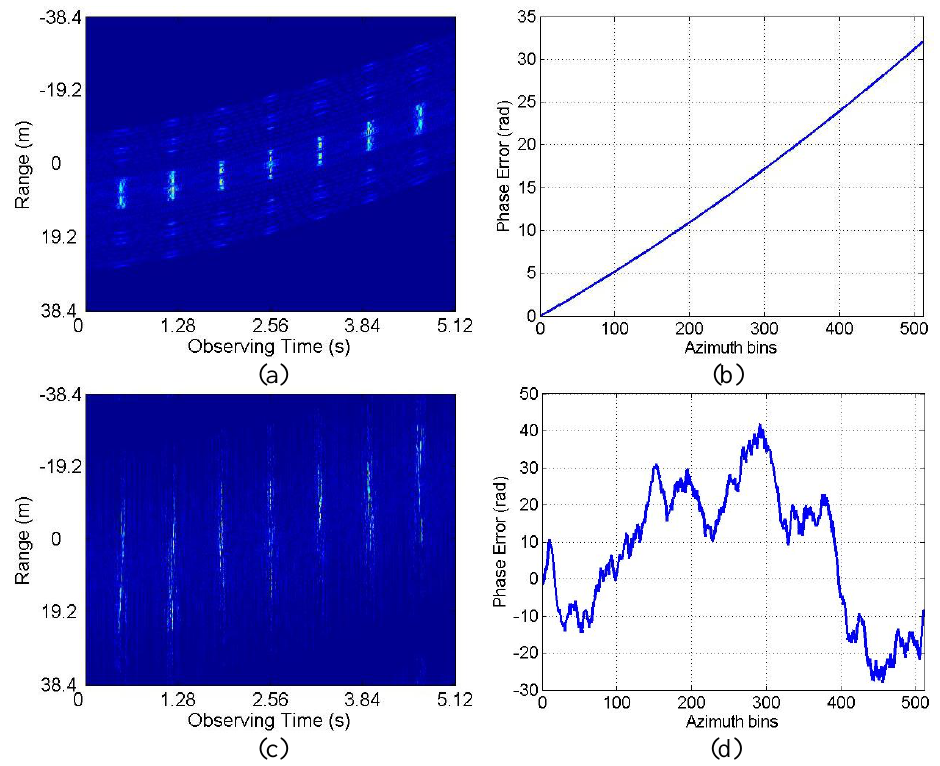
Figure 4. HRRPs and phase errors. CM: ( a ) HRRPs. ( b ) Phase errors. NCM: ( c ) HRRPs. ( d ) Phase